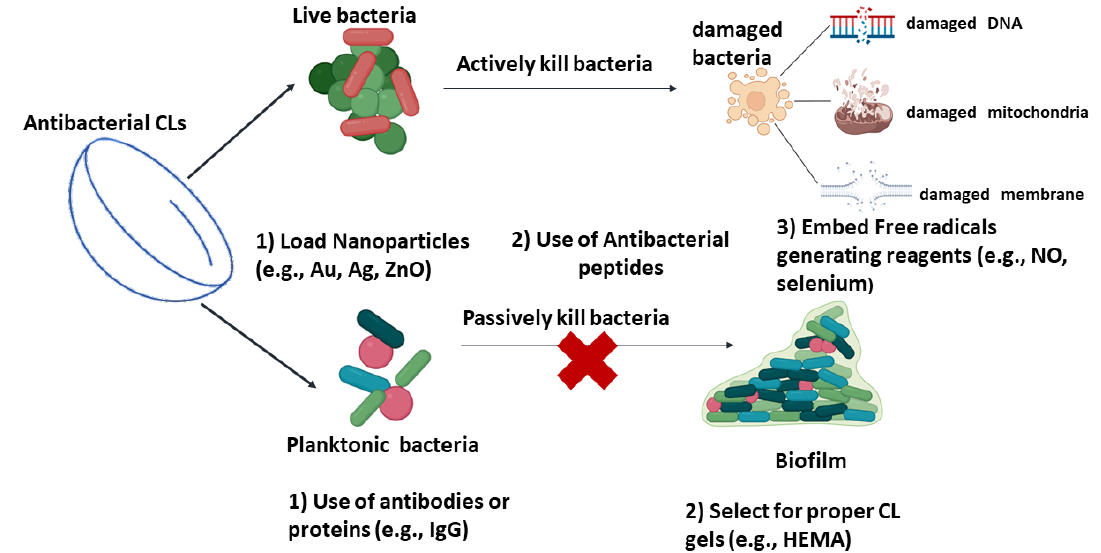
Figure 2 . Strategies applied in CLs for bacterial